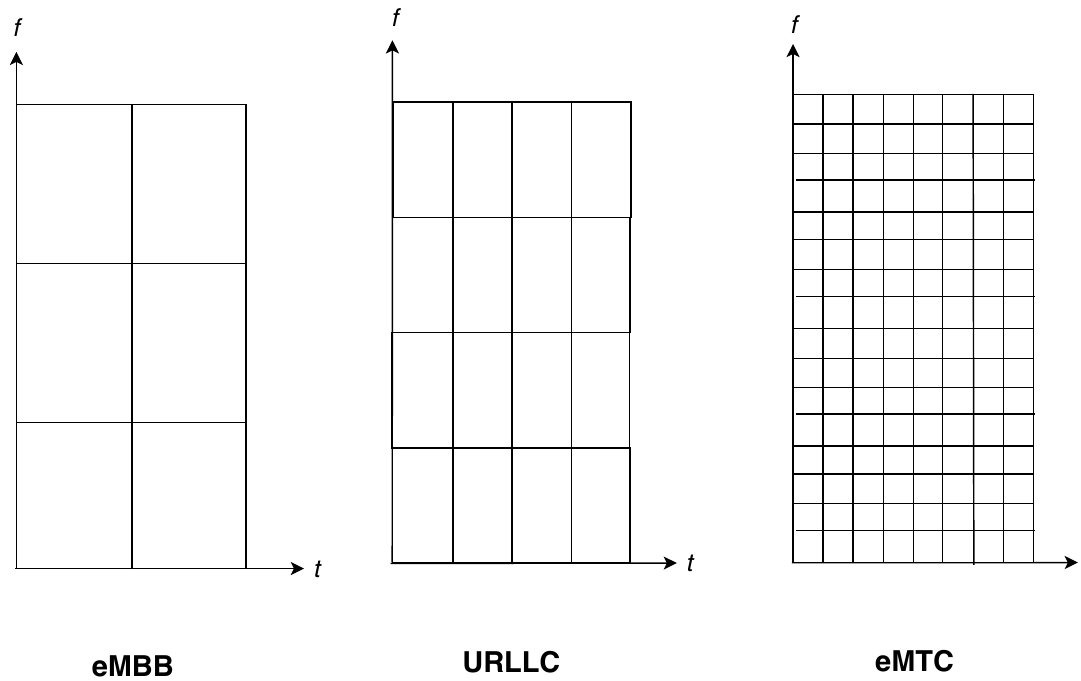
Figure 1. International Mobile Telecommunication (IMT)-2020 use-cases from Frequency Division Duplexing (FDD)/Time Division Duplexing (TDD) perspectives. eMBB, enhanced Mobile Broadband; URLLC, Ultra-Reliable Low Latency Communication; eMTC, enhanced Machine Type